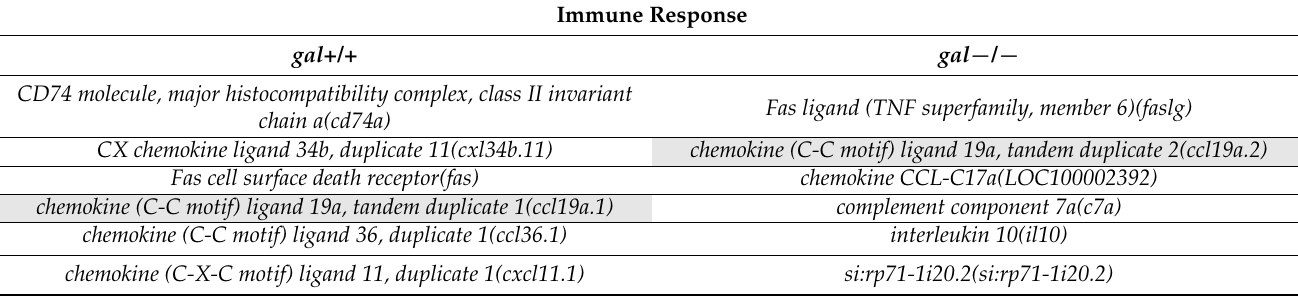
Table 2. Comparisons of affected genes in biological processes in gal+/+ wild-type and gal − / − mutant larvae after M. marinum infection. Common genes are marked as